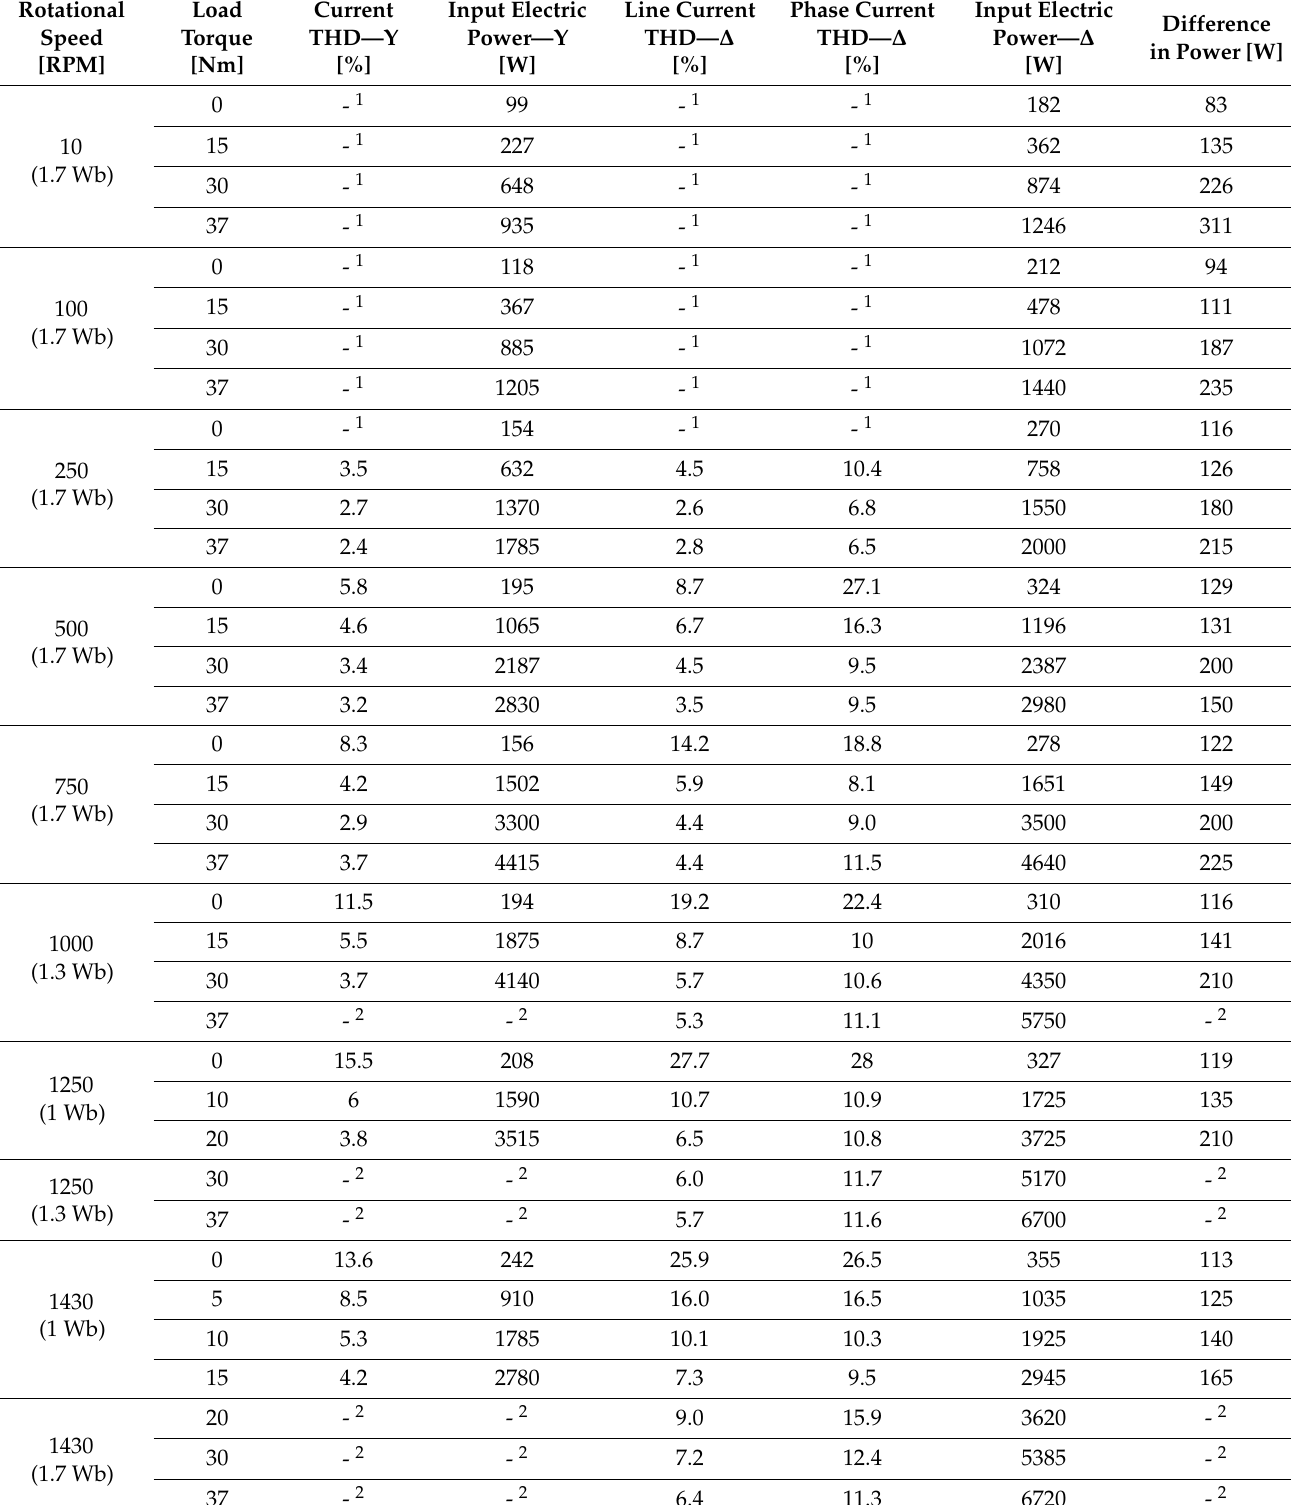
Table 2. Comparison of current the total harmonic distortion (THD) and input electric power in multiple operating points for a delta and star winding